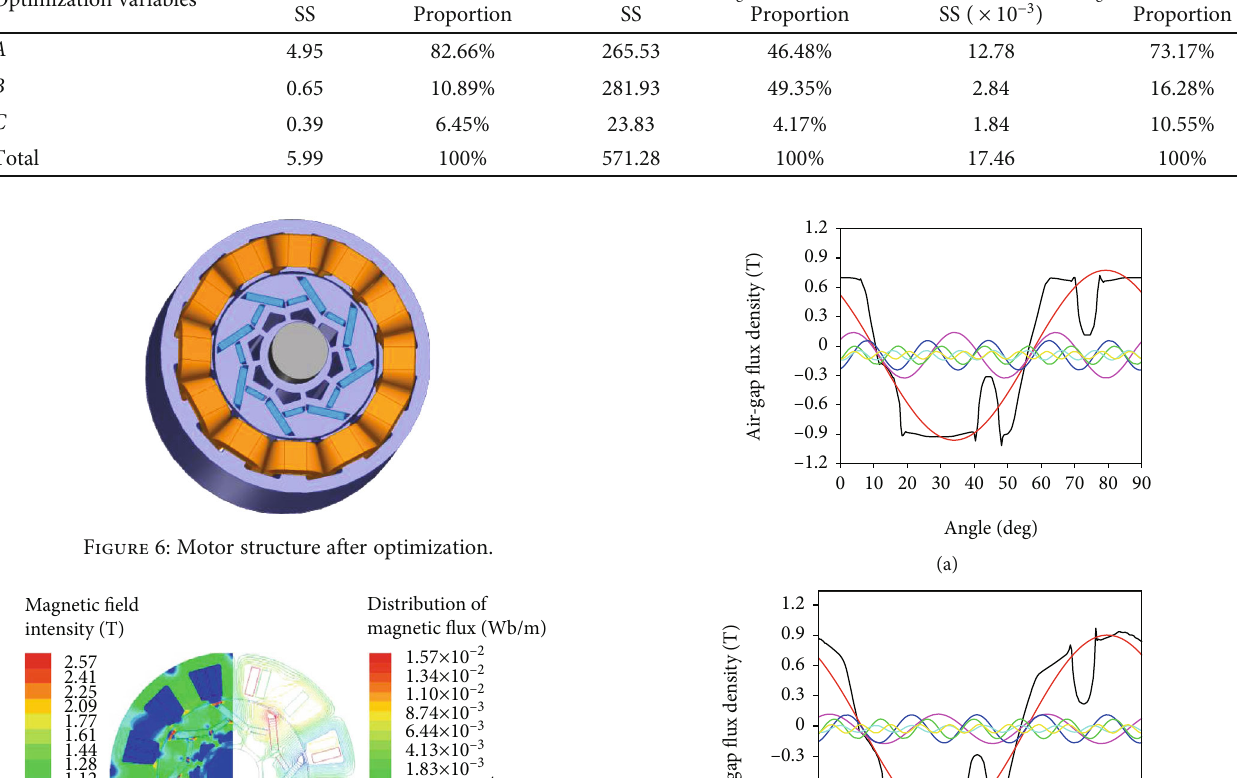
Table 9: The proportions of the in fl uence of each optimization variable on the optimization goal. Optimization variables